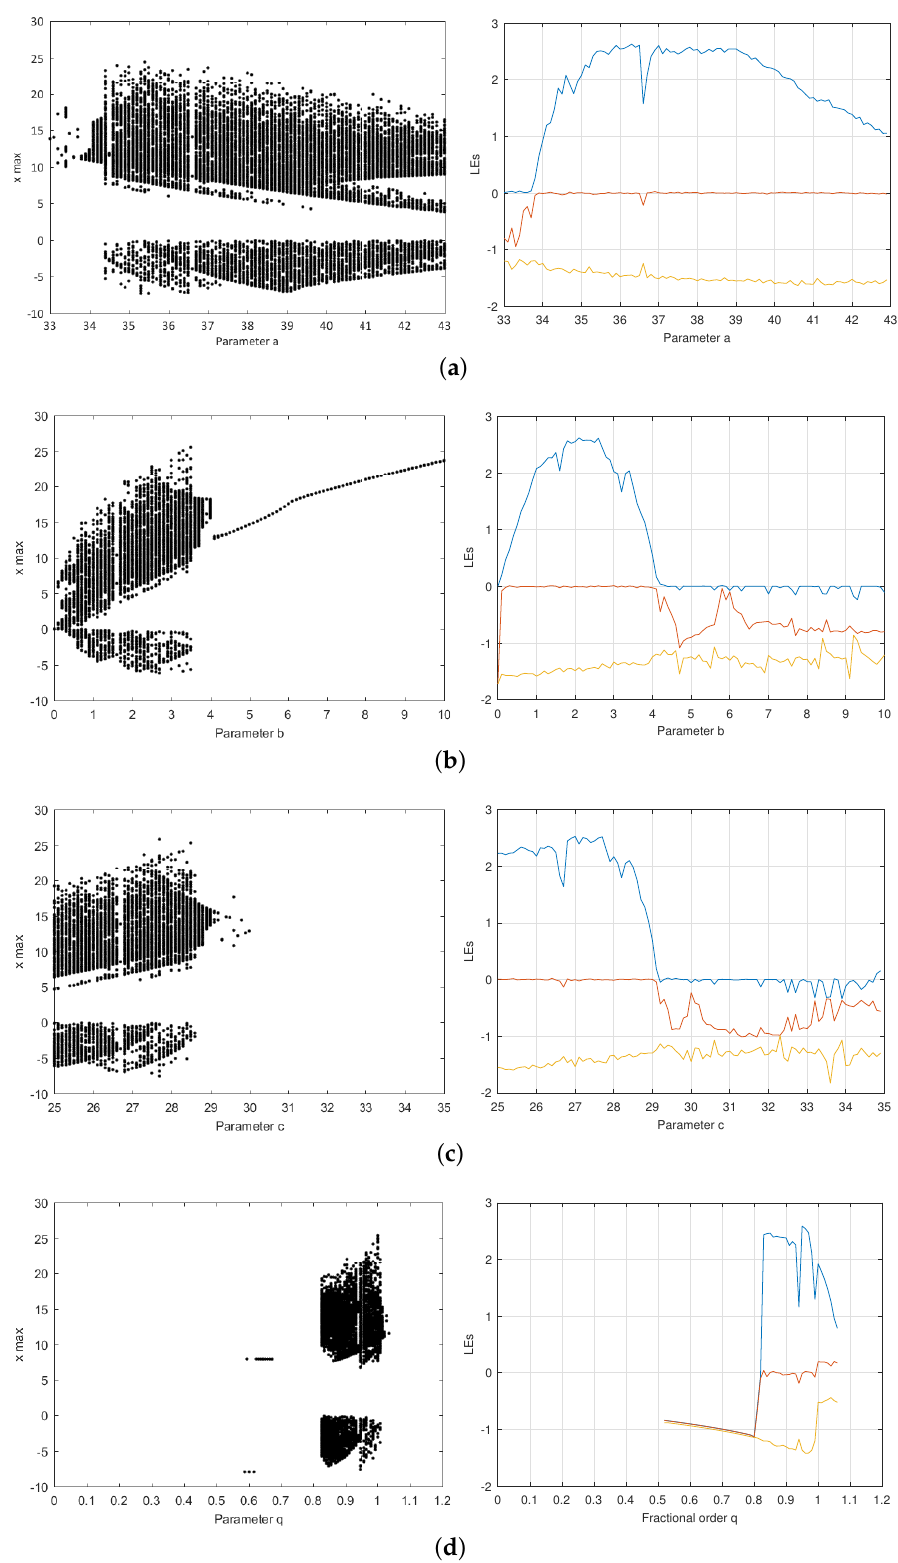
Figure 3. Bifurcation diagram and LE spectra of non-optimized fractional order Chen system. For the LE spectra, L 1 is in blue color, L 2 in red, and L 3 in yellow. a = 35, b = 3, c = 28, q = 0.9800 and MLE = 2.0293. ( a ) Parameter a ( b ) Parameter b ( c ) Parameter c ( d ) Fractional order q